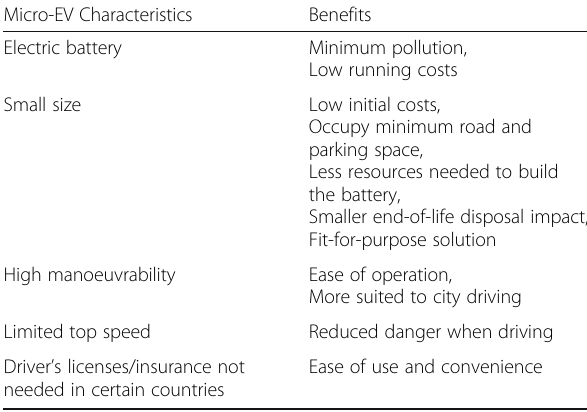
Table 1 Summarised micro-EV benefits Micro-EV